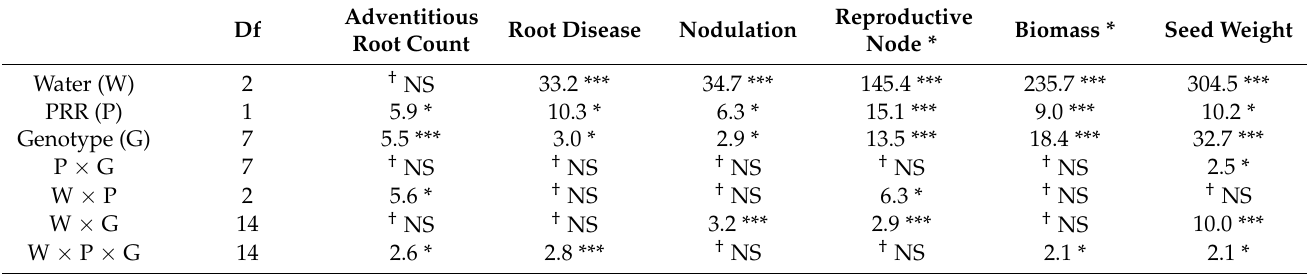
Table 2. Mean values and 5 – 95% CI in parentheses for the three-way GLMM for early and late veg- etative waterlogging (WL) and P. medicaginis infection (PRR) for disease and growth parameters of three chickpea genotypes (Geno) C. echinospermum BC PRR moderately resistant 04067, C. arietinum PRR moderately susceptible Yorker and PRR very susceptible Rupali. Table 1. Wald test of GLMM effects for growth and disease parameters in a three-way interaction for chickpea genotypes ( C. echinospermum BC PRR moderately resistant 04067, C. arietinum PRR moderately susceptible Yorker and PRR very susceptible Rupali); water treatment (field capacity, early and late vegetative waterlogging); and uninoculated or P. medicaginis inoculated (PRR) status. F-values and the corresponding p -values are displayed.